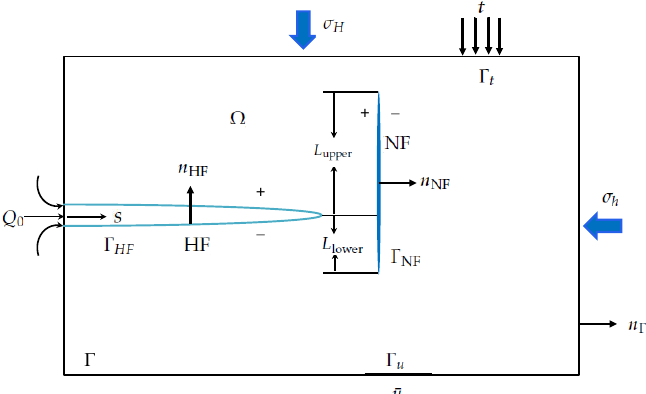
Figure 1. Schematic diagram of a hydro-fracture (HF) intersection with a natural fracture